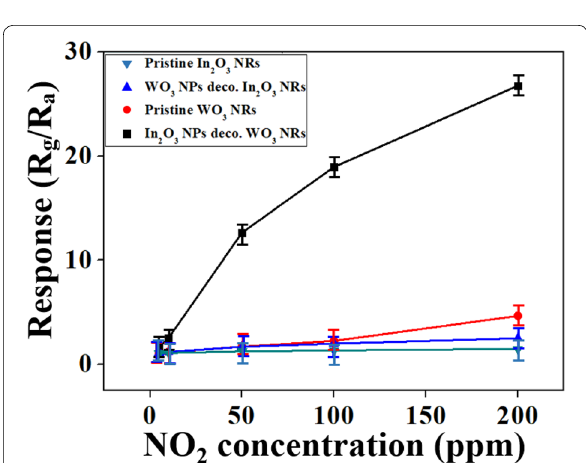
Fig. 6 Calibration curves for responses of pristine and In 2 O 3 NPs‑decorated WO 3 to NO 2 as well as those of pristine and WO 3 NPs‑decorated In 2 O 3 NRs to NO 2 as a function of NO 2